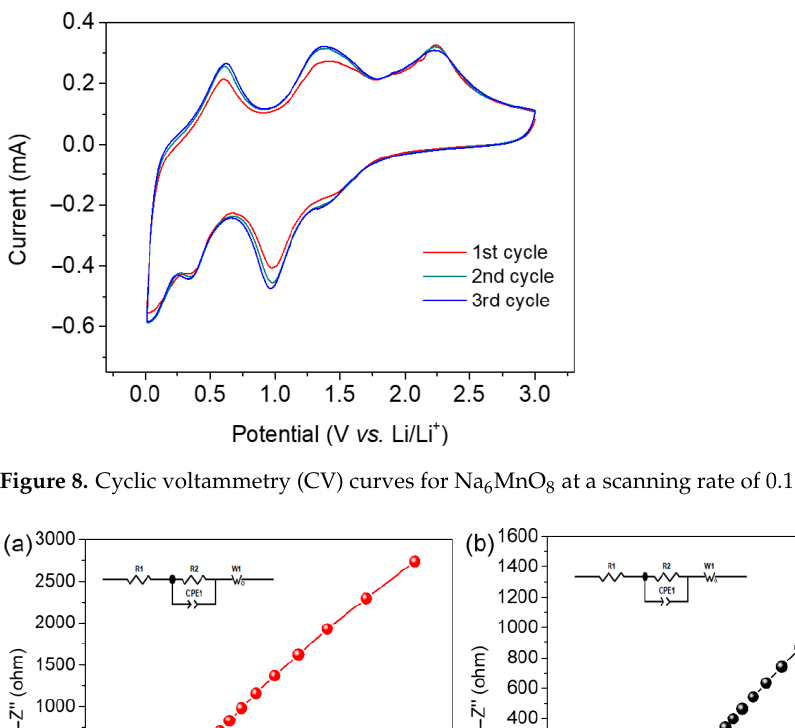
Figure 8. Cyclic voltammetry (CV) curves for Na 6 MnO 8 at a scanning rate of 0.1 mV g −1 .